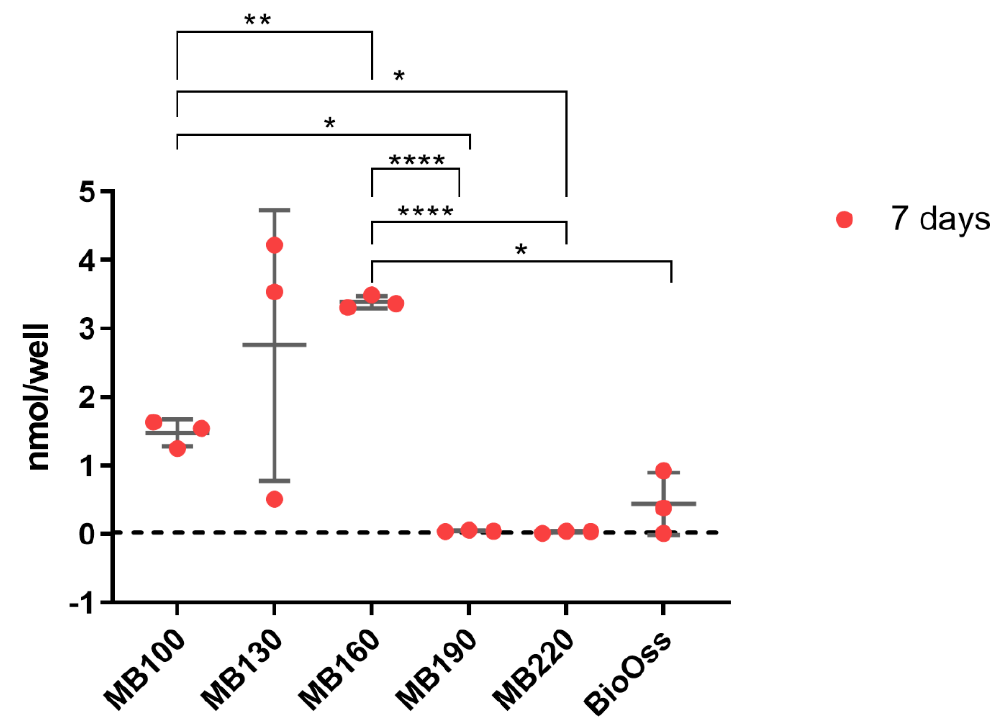
Figure 5. Alkaline phosphatase production determined from osteoblasts cultured on bone scaffold specimens at 7 days. N=3. Results expressed as mean ± SD. Dotted line: 7 − day negative control. Sig − ificant values * p ≤ 0.05, ** p ≤ 0.01, **** p ≤ 0.0001.